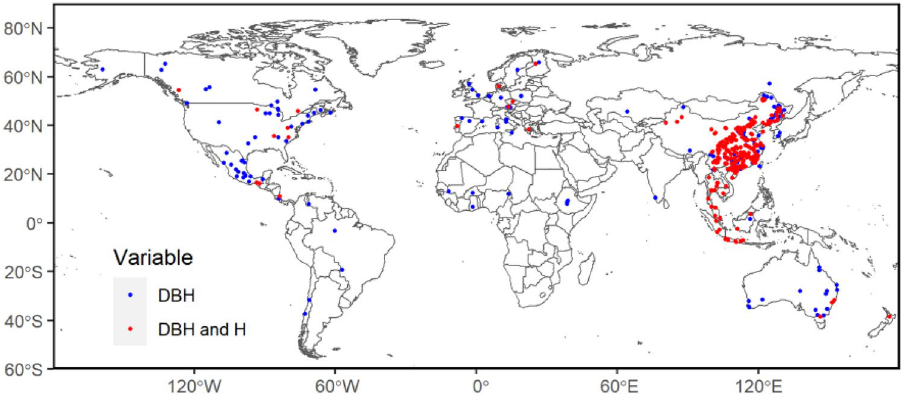
Figure 1. Geographical distribution of the collected allometric models. Blue circles represent the distribution of sites for the DBH (tree diameter at the breast height) alone model (LnW = a + b*Ln(D)) parameters; Red circles represent the distribution of sits for the DBH and H (tree height) model (LnW = a + b*Ln(D 2 H)) parameters. The map is created in R 4.0.3 (URL https:// www.R- proje ct.